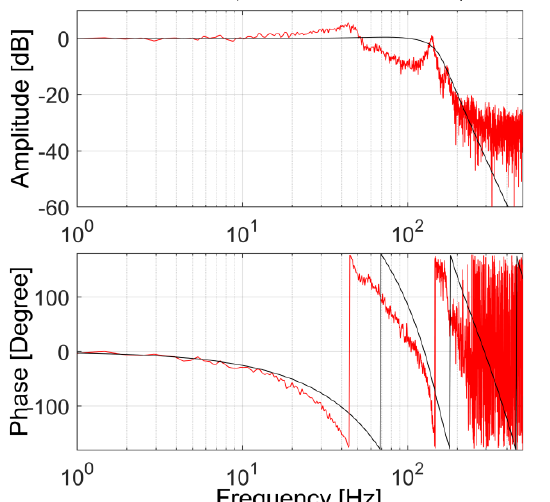
Fig. 12. Comparison of synthesis results with experimental data ( Butterworth filter, experimental